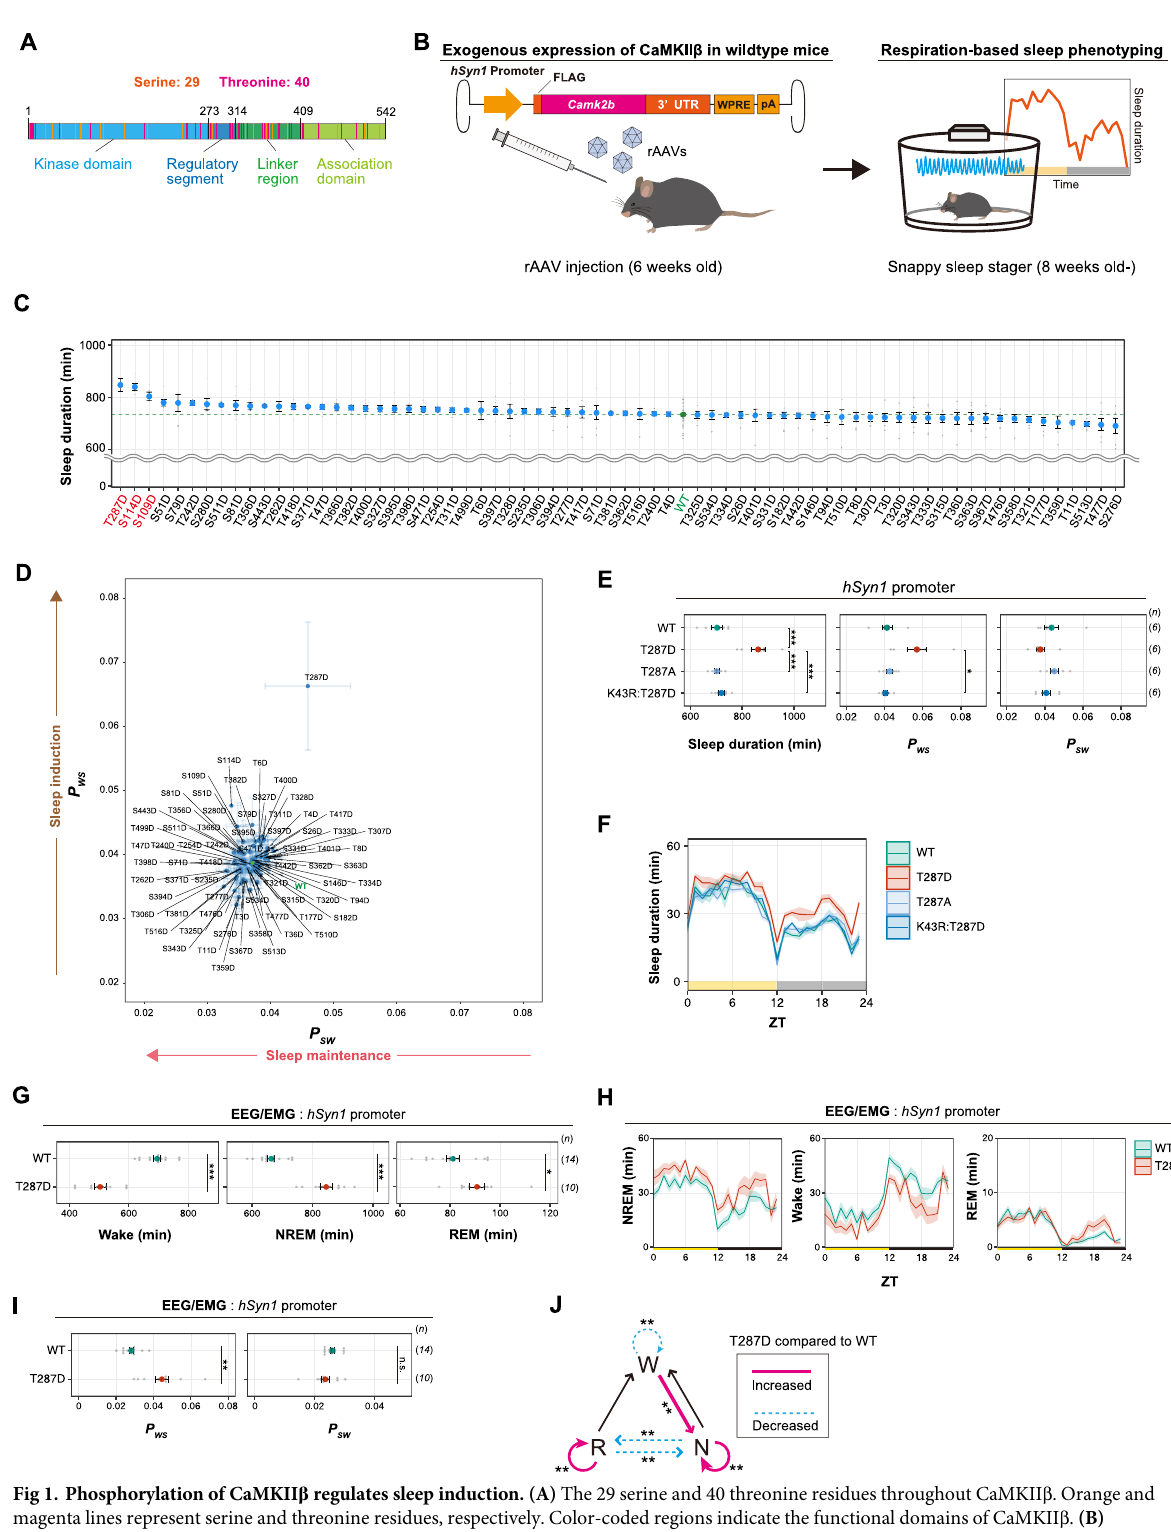
PLOS Biology | https://doi.org/10.1371/journal.pbio.3001813 October 4,